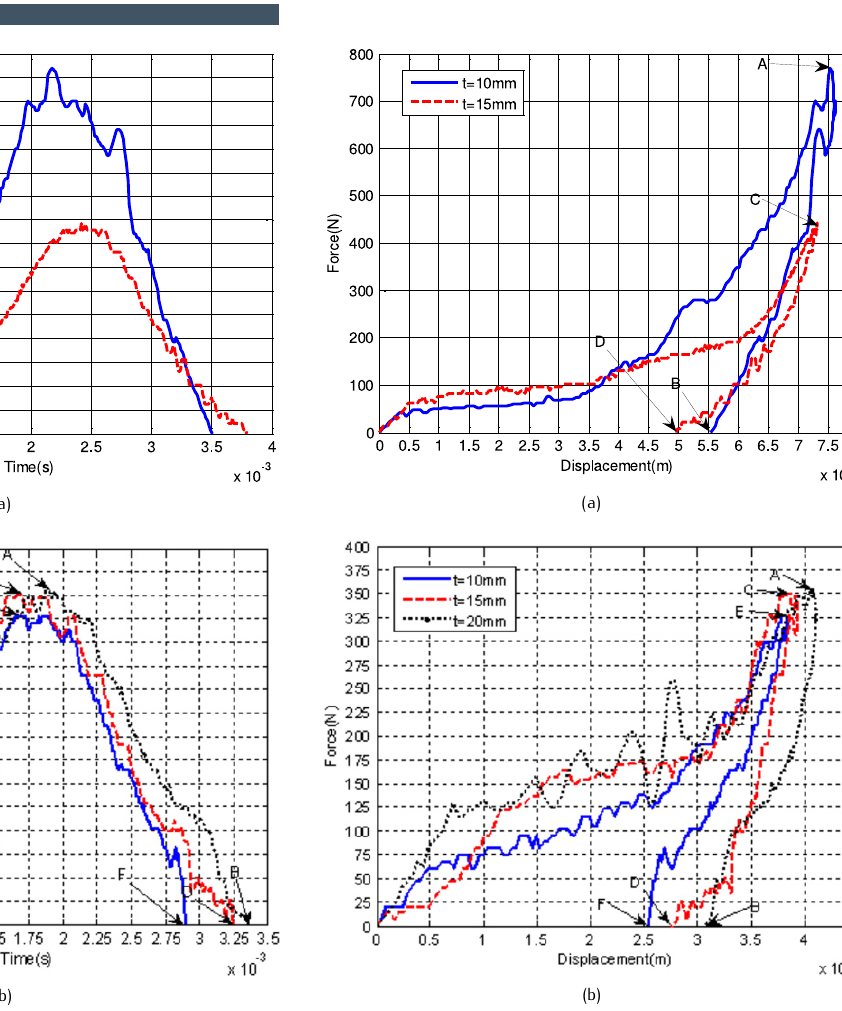
Figure 13. Contact force history for crushable foams: (a) PUR; (b) EPP